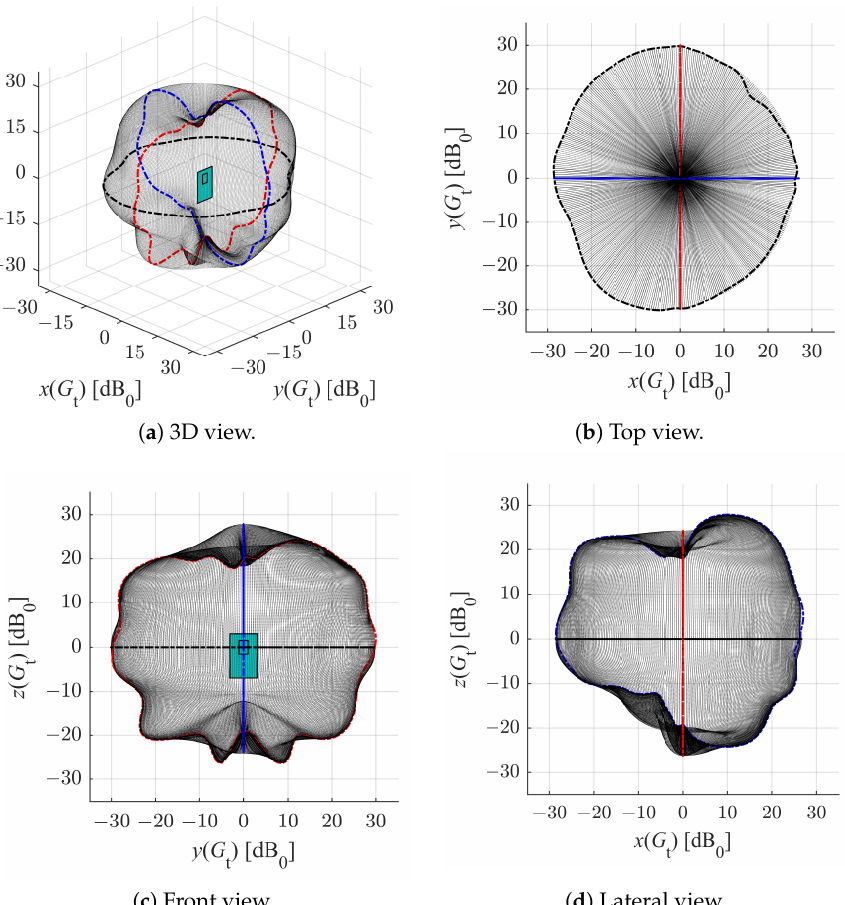
Figure 4. Views of the reconstructed 3D radiation pattern of an anchor